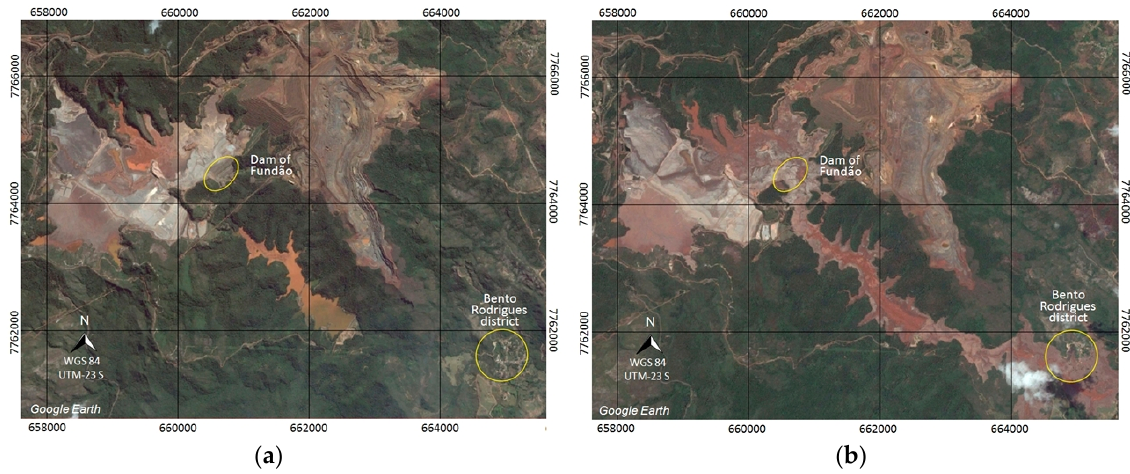
Figure 2. Images (Landsat) over Germano Complex area before (20 July 2015) ( a ) and after (9 November 2015) ( b ) the Fundão dam rupture.